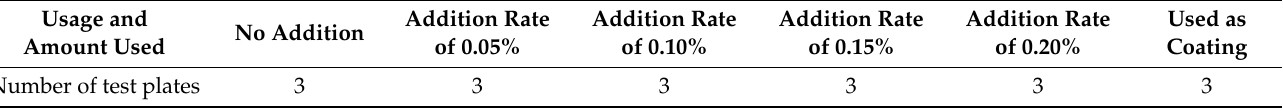
Table 2. Experimental setup of concrete specimens for the test plate group.